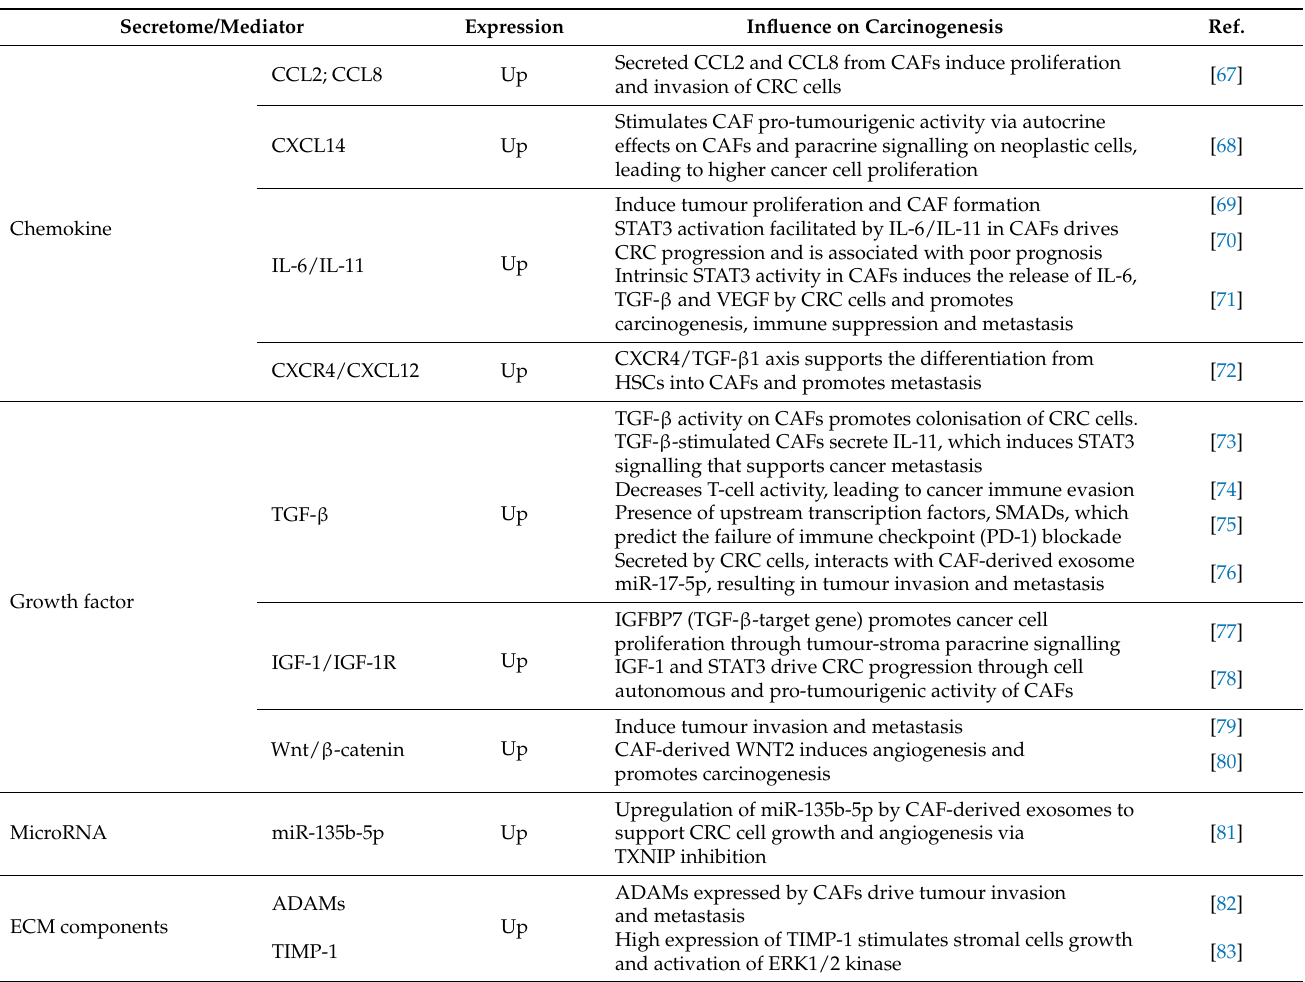
Table 1. Paracrine and autocrine interactions between CAFs and CRC cells in relation to poor prognosis CRC